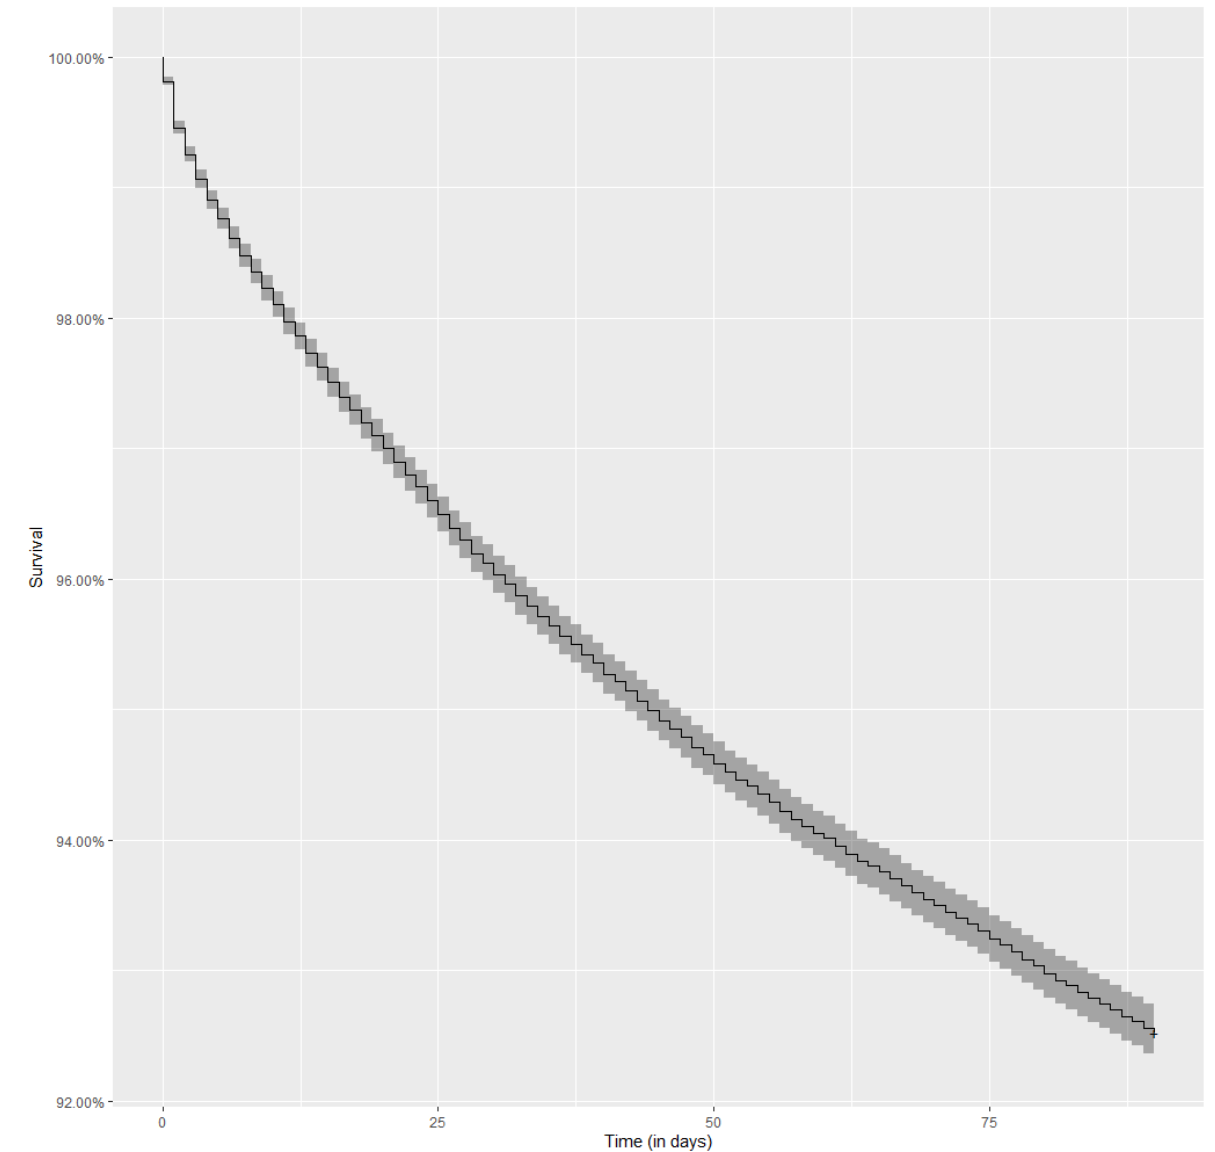
Figure 3. Kaplan–Meier curve representing the risk of death over a period of 90 days after a discharge from a diabetes-related index